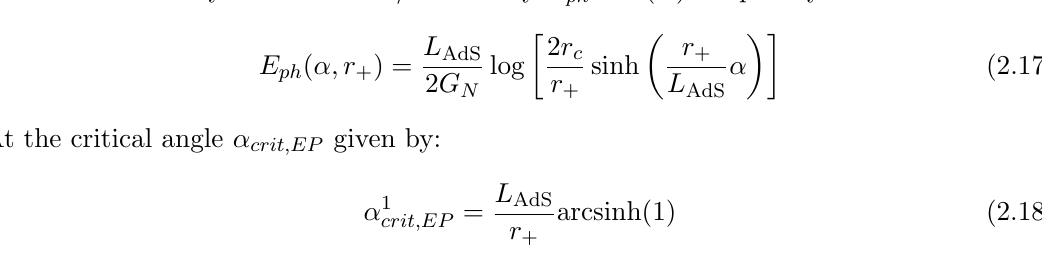
Figure 6. Left: plot of E ph for the case where A has half-width (cid:11) and B has half-width (cid:25) (cid:0) (cid:11) for 3 di(cid:11)erent choices of the horizon: r + =L = 1 (red), r + =L AdS = 2 (green) and r + =L = 5 (black). Right: plot of the E ph (green) and half the mutual information (black) as a function of (cid:11) , with r + =L AdS = 1. In both panels, we set the radial cuto(cid:11) to r c =L AdS = 10 and 4 G N = 1. the E ph is computed by the RT surface for the smaller region. This is depicted in the right panel of (cid:12)gure